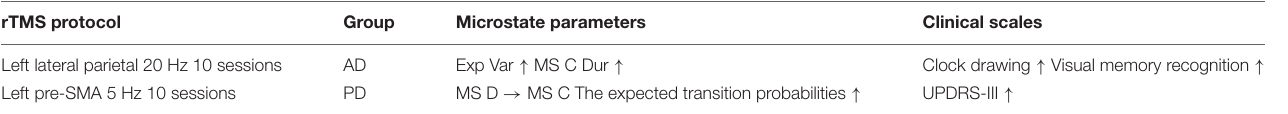
Black arrows represents transitions between microstates. TABLE 6 | The results of microstate parameters and clinical scales of rTMS of AD and PD groups. rTMS